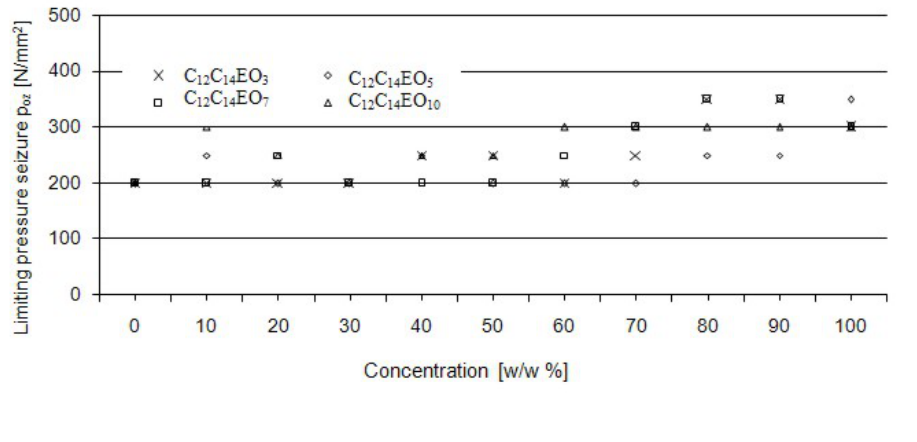
) of oz -C EO , 5–C -C EO 12 14 3 12 14 5